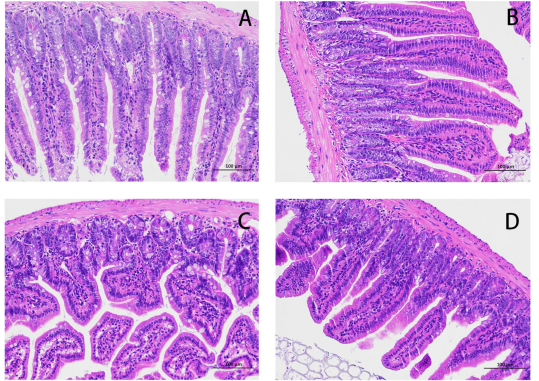
Figure 1. HE staining of mouse jejunum tissue (200 × ). Note: ( A ): CON group, ( B ): L.S group, ( C ): E. coli group, ( D ): L.S + E. coli group.